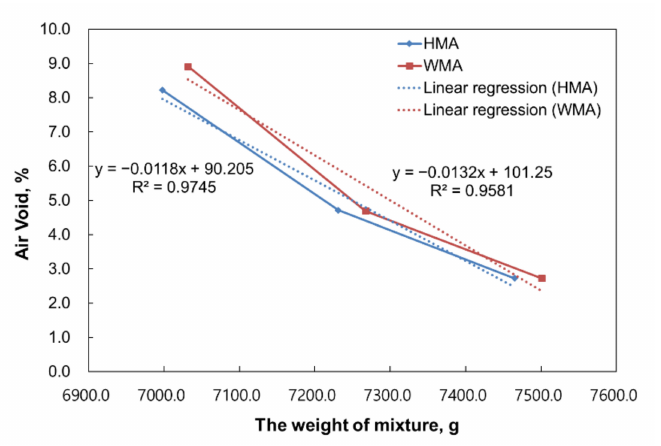
Figure 2. Correlation between the amount of asphalt mixture and air